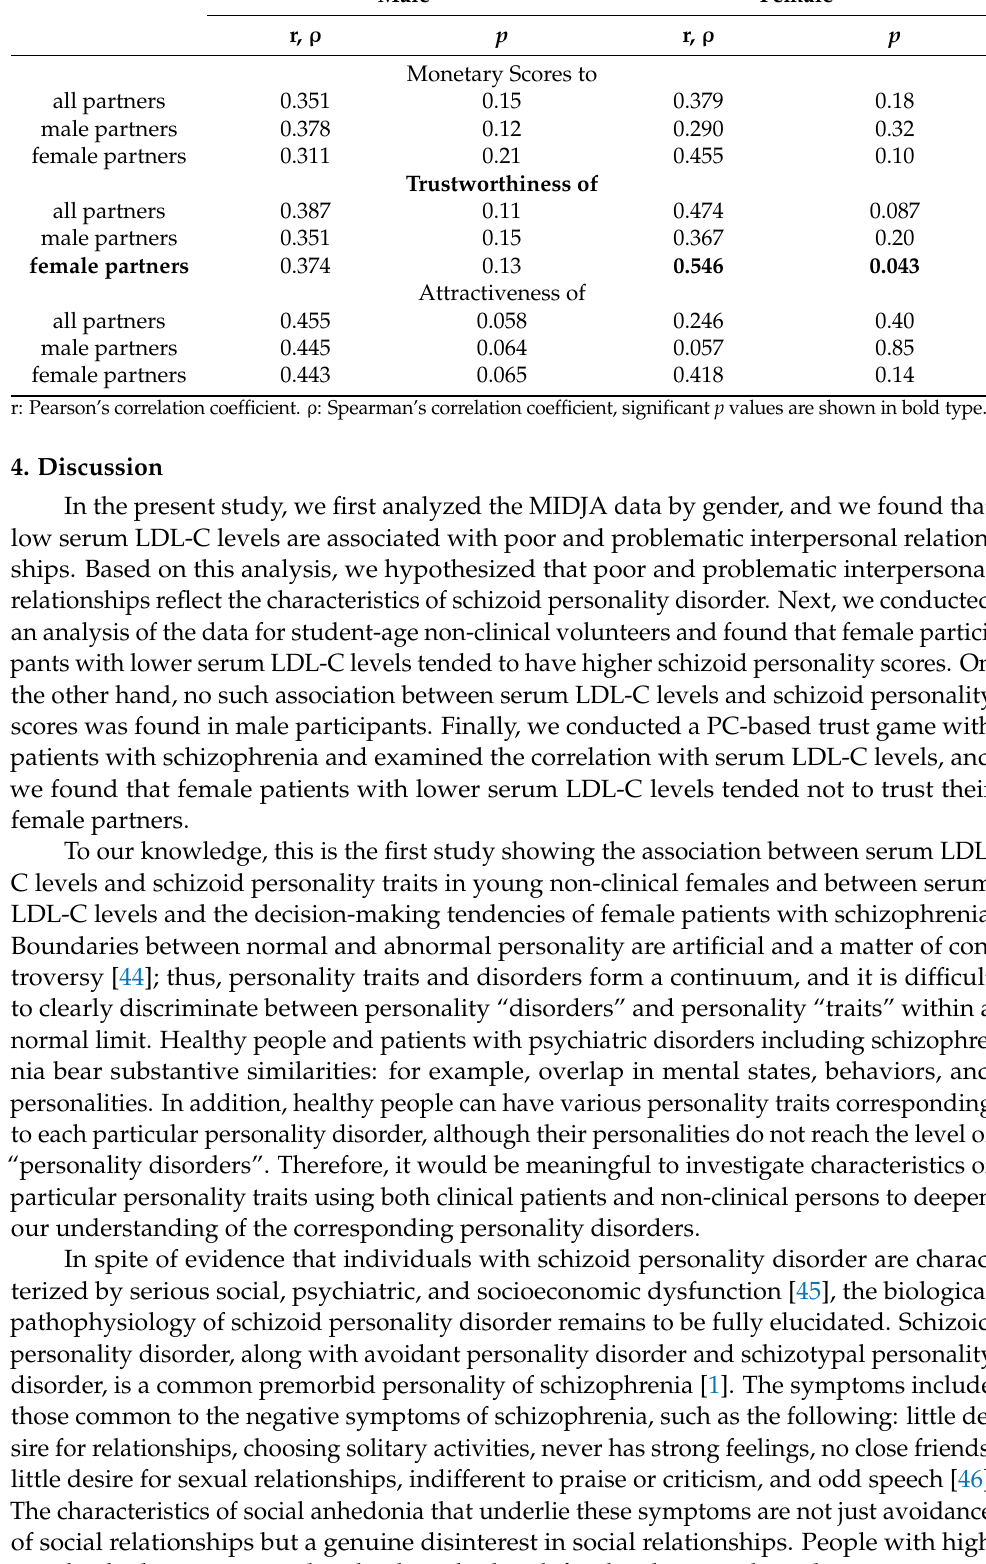
Table 5. The relationships between serum LDL-C levels and the results of a PC-based trust game. Serum LDL-C